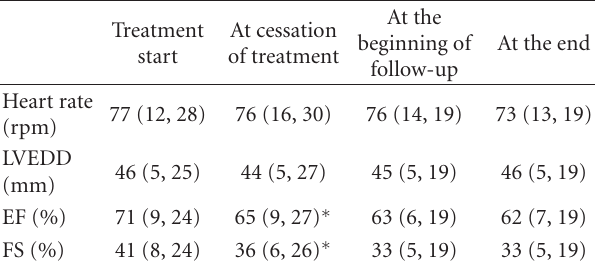
Table 1: Mean values for heart rate, left ventricular enddiastolic dimension (LVEDD), ejection fraction (EF), and fractional shorten- ing (FS). Standard deviation and number of patients in parenthesis. ∗ P value ≤ .